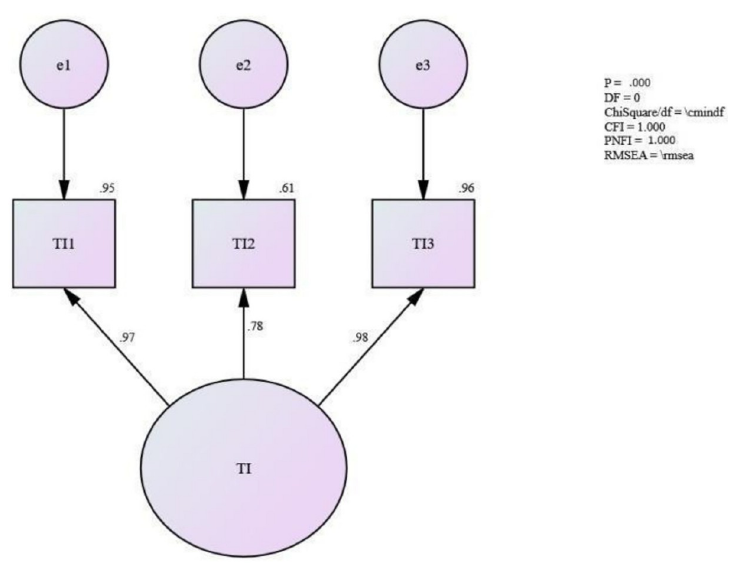
Fig 6. Measurement model for employee turnover